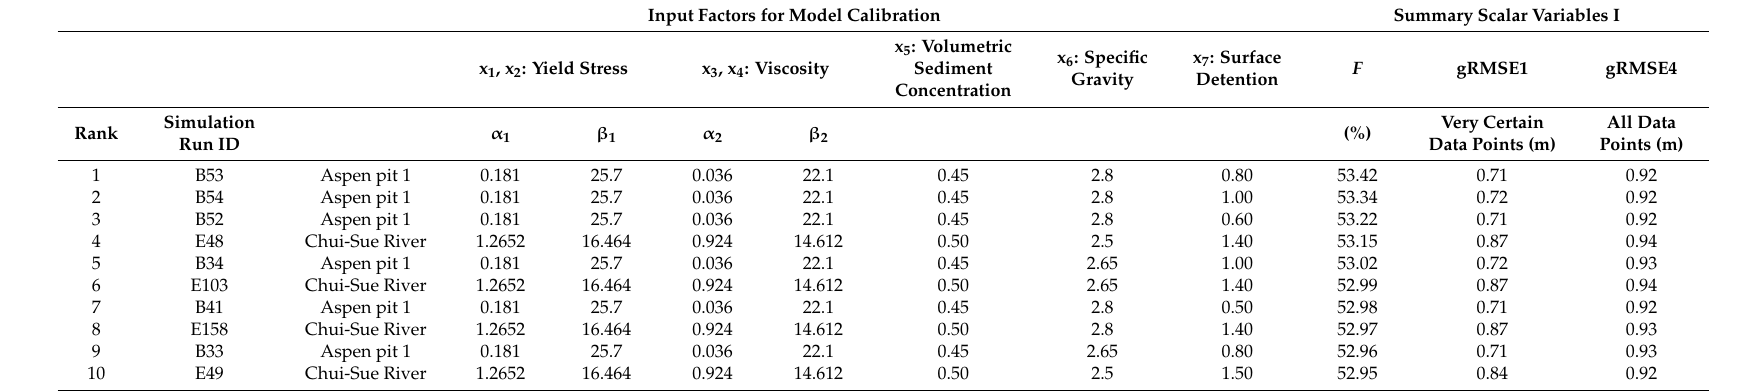
Table 4. Overview of top 10 performing simulations based on highest F fitness measurement values.